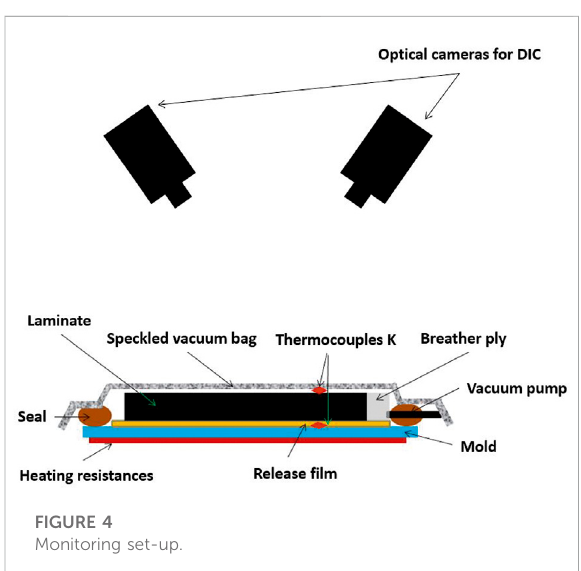
FIGURE 4 Monitoring